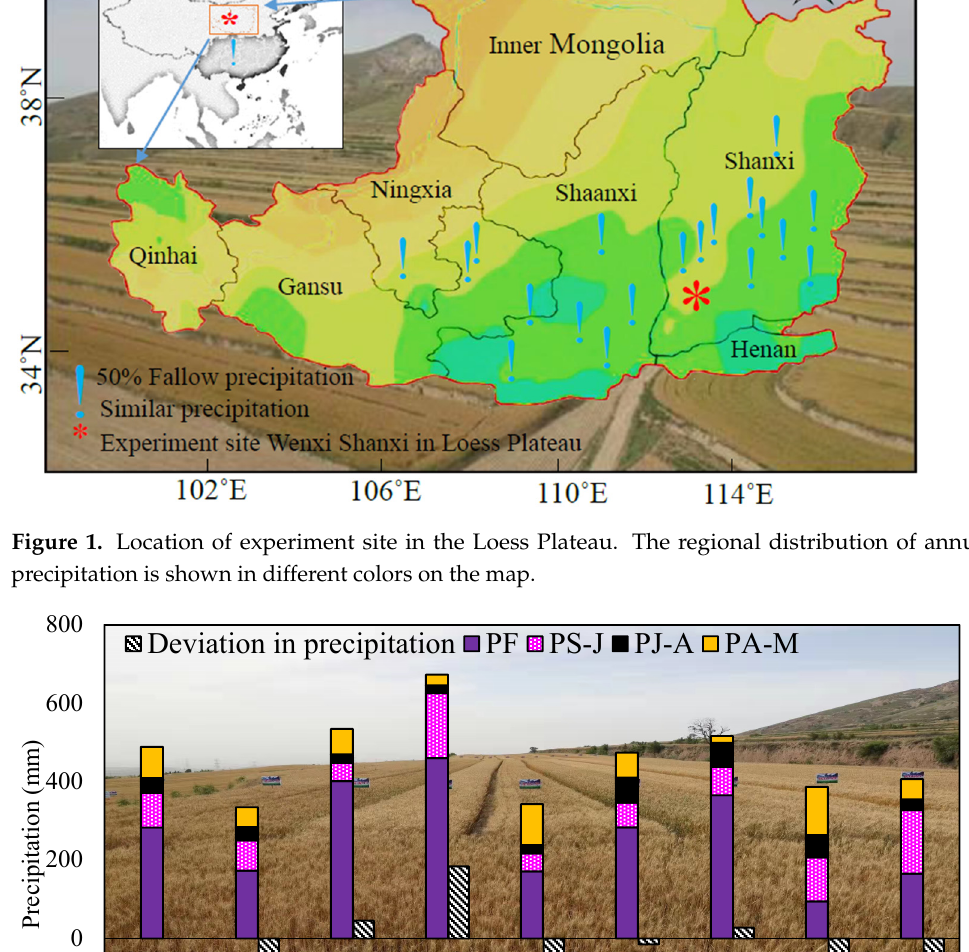
Figure 2. Precipitation distribution in the study area from 2009 to 2017, during the growth stage of winter wheat and the fallow season. P F , P S -J, P J -A, and P A -M denote the precipitation during the fallow, sowing, anthesis, and maturity stages of wheat, respectively.